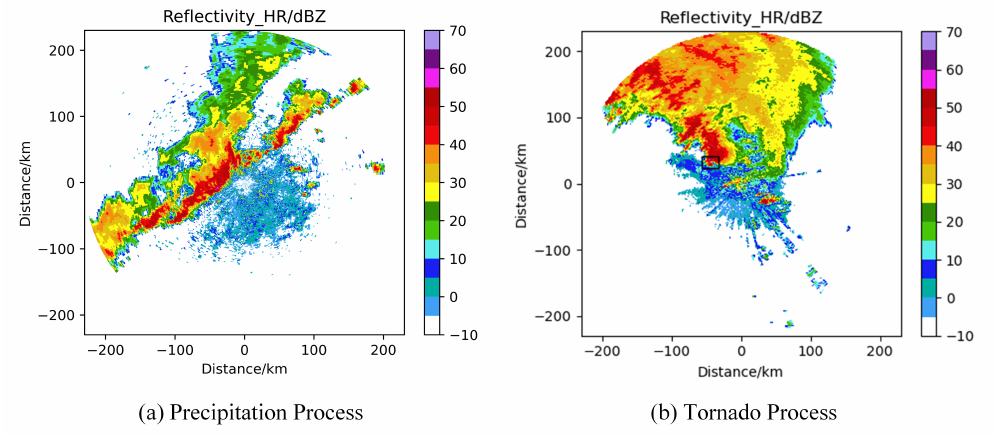
Figure 9. High-resolution representation of weather radar